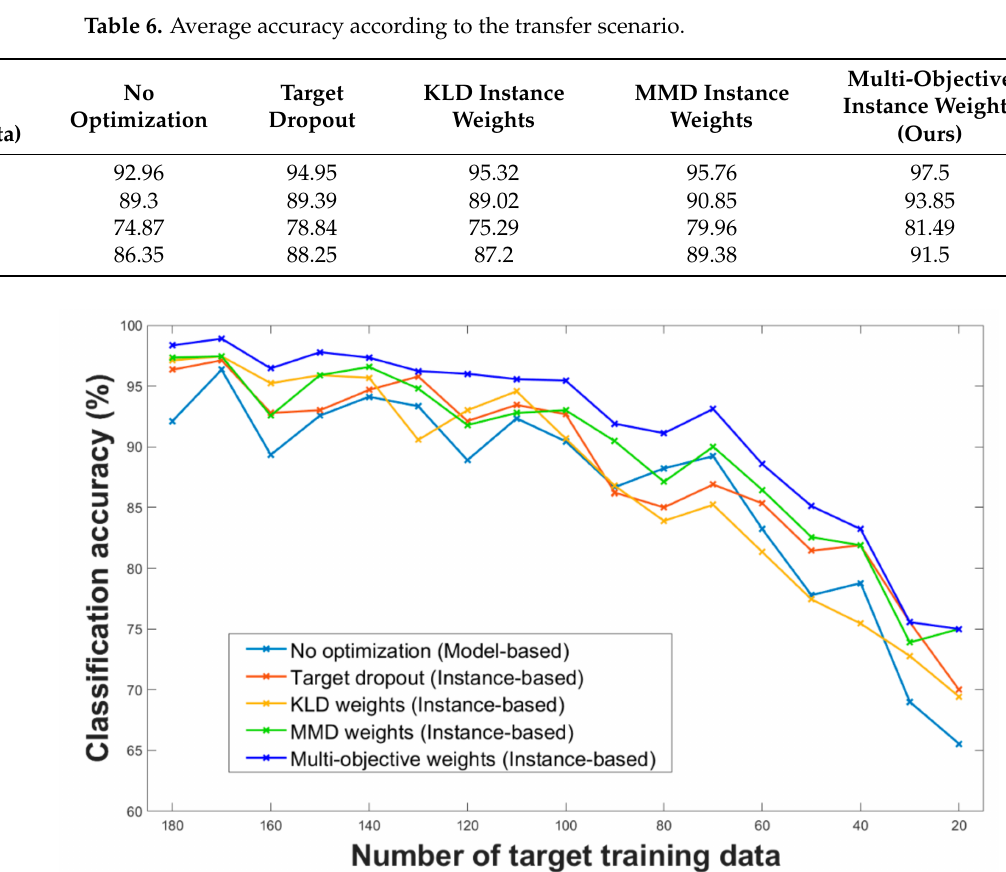
Figure 7. Comparison results between different domain optimization